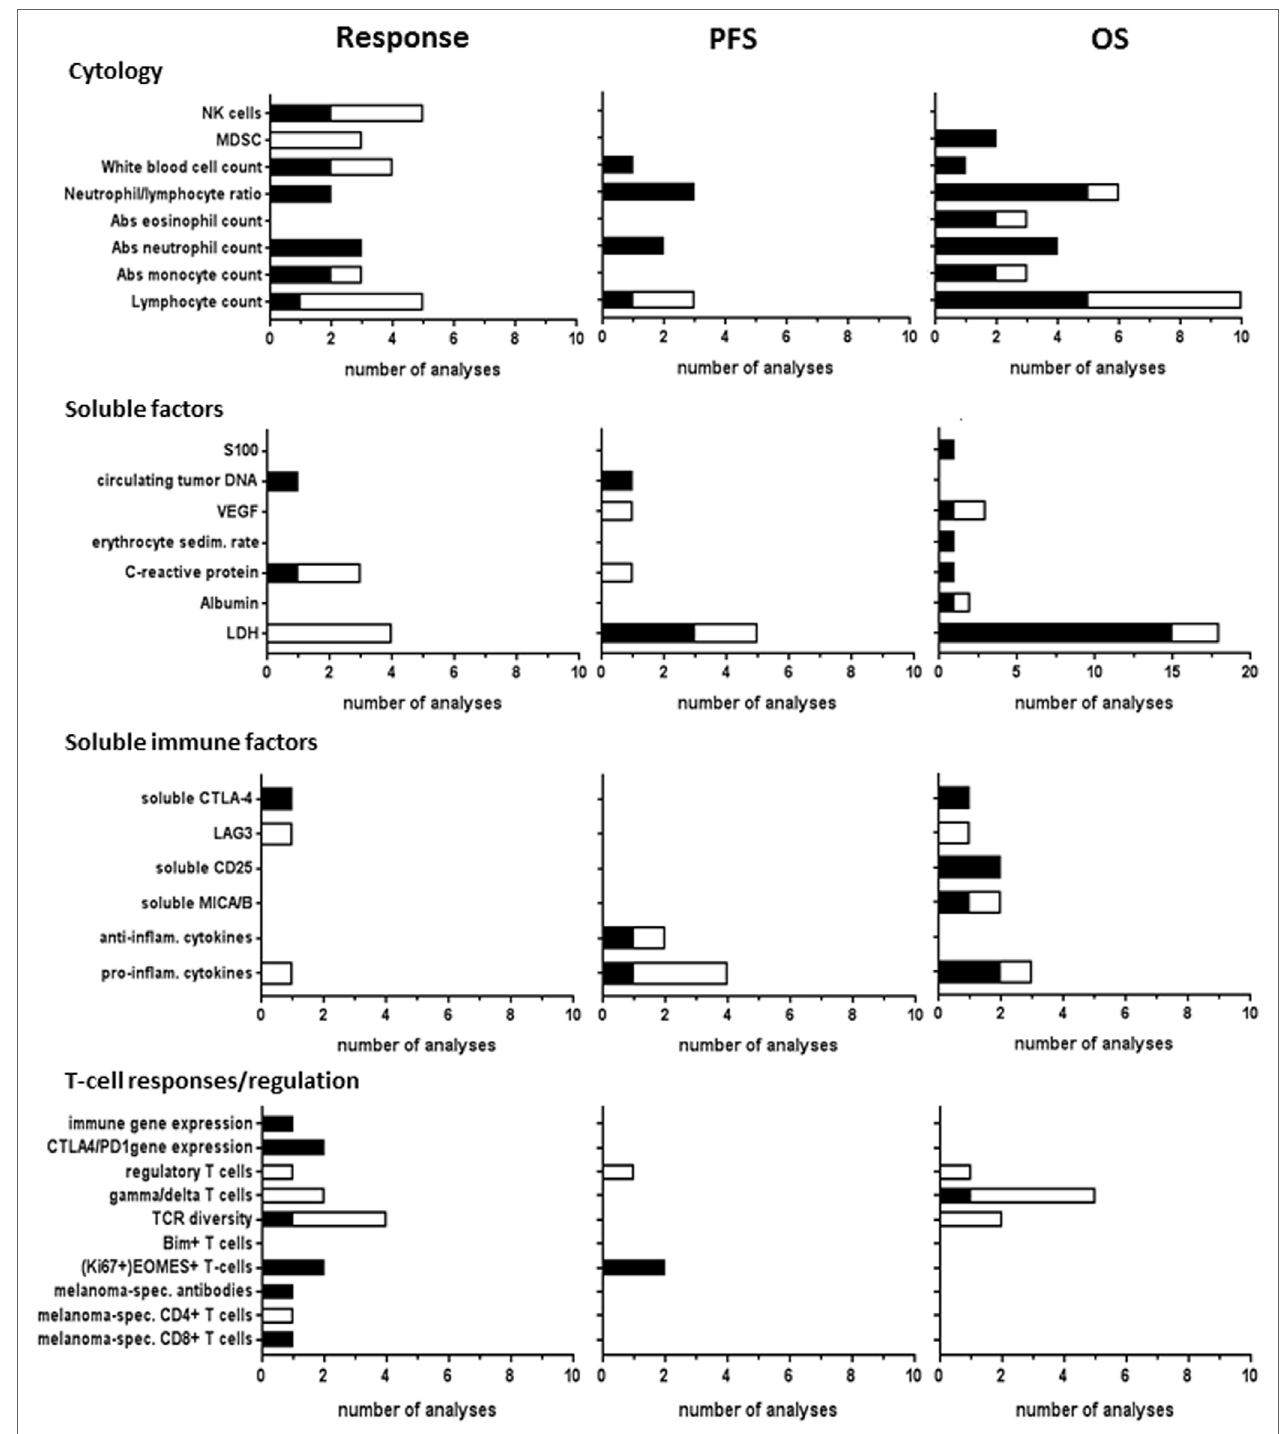
FiGURe 4 | Blood biomarkers analyzed for CTLA-4 immune checkpoint inhibitor (ICI). Graphs show the number of analyses per biomarker type for correlations with clinical response, progression-free survival (PFS), or overall survival (OS) upon CTLA-4 ICI therapy. Black bars, significant correlation; white bars, non-significant